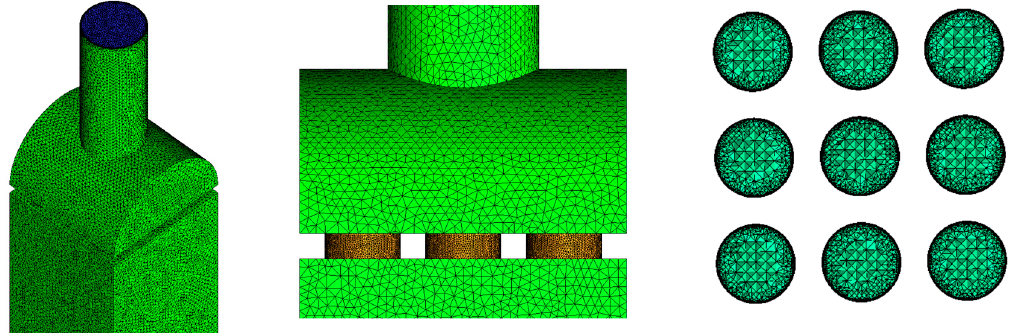
Figure 5. Computational grid of the entrance head with 3 × 3 SPB.